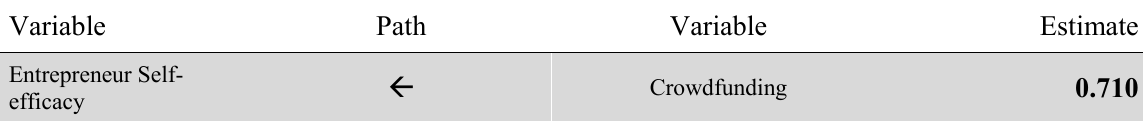
Standardized Regression Weights of CE on IP